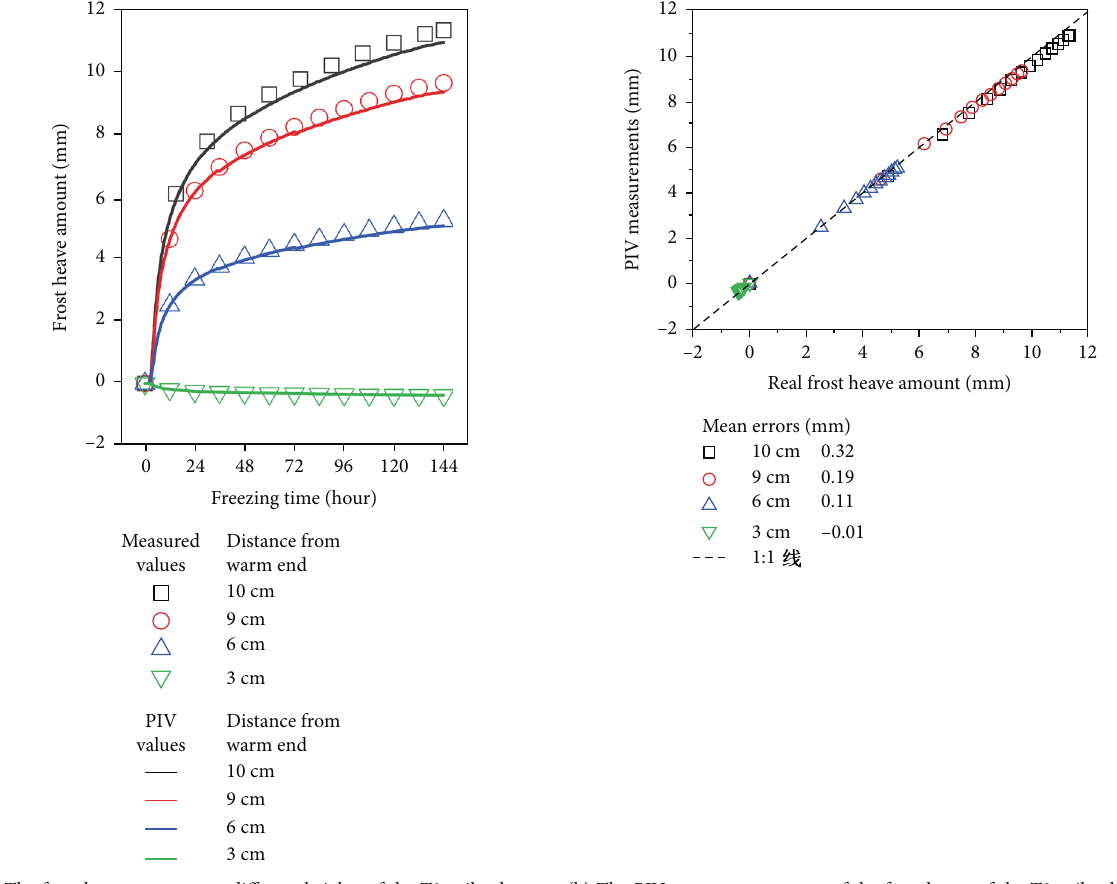
Figure 11: Frost heave amounts at di ff erent heights of the T2 soil column.